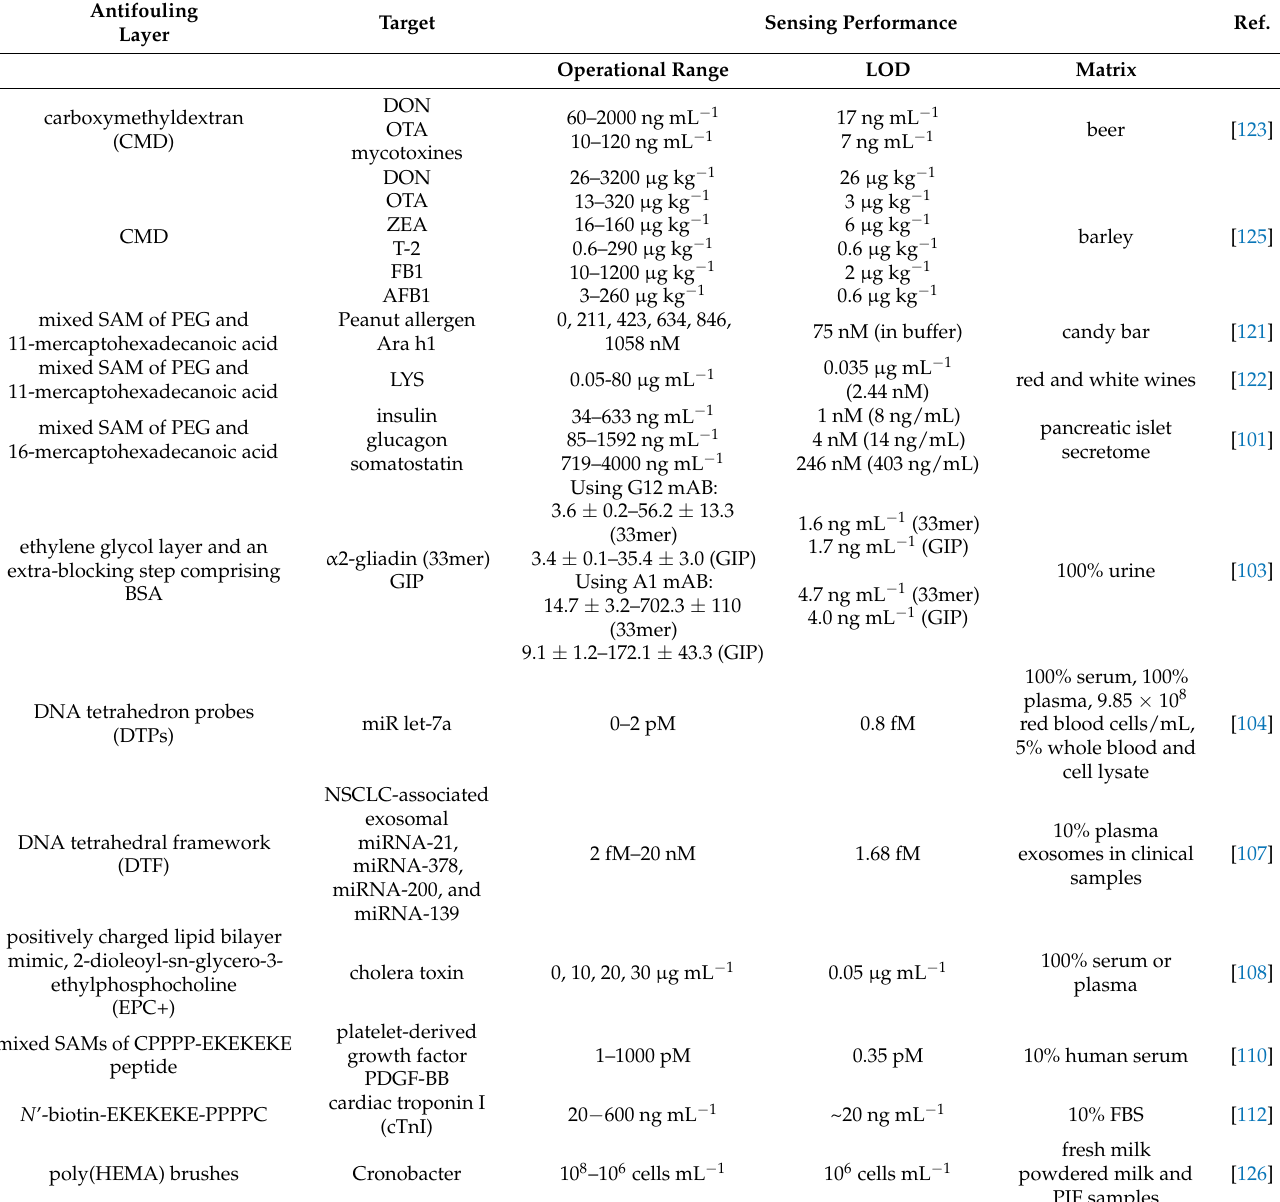
Table 1. Summary of the SPR biosensing approaches aimed at detecting different targets of interest, indicating the antifouling layer used, performances of the SPR sensors in terms of limit of detection (LOD), working range, and matrix type. Antifouling Target Sensing Performance Layer